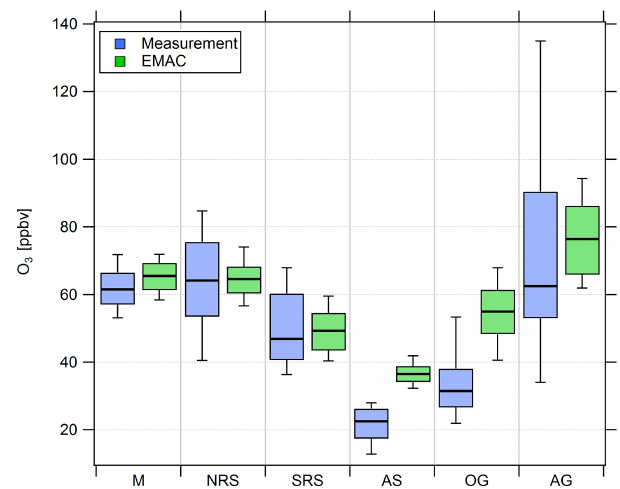
Figure 5. Comparison of measured (blue) and simulated (green) O 3 mixing ratios in the six different regions investigated during AQABA. The horizontal black bar indicates the median value, the box shows the 25th and 75th percentiles, and the whiskers show the 10th and 90th